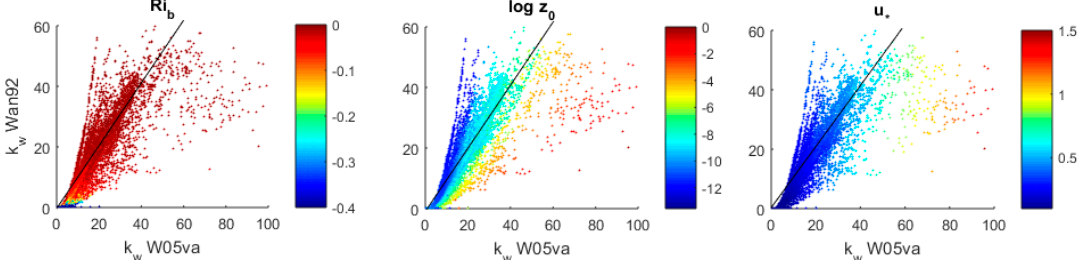
Figure 6. Comparing the formulation by Wanninkhof [29] (Wan92) to the formulation by Woolf [44] (W05va) using modelled data about the European coastal ocean. Differences in the estimates of transfer velocity (k w ) as functions of the bulk Richardson number (Ri b ), roughness length (z 0 ) and friction velocity (u * ). The 1:1 line (in black) represent equal k w estimates.